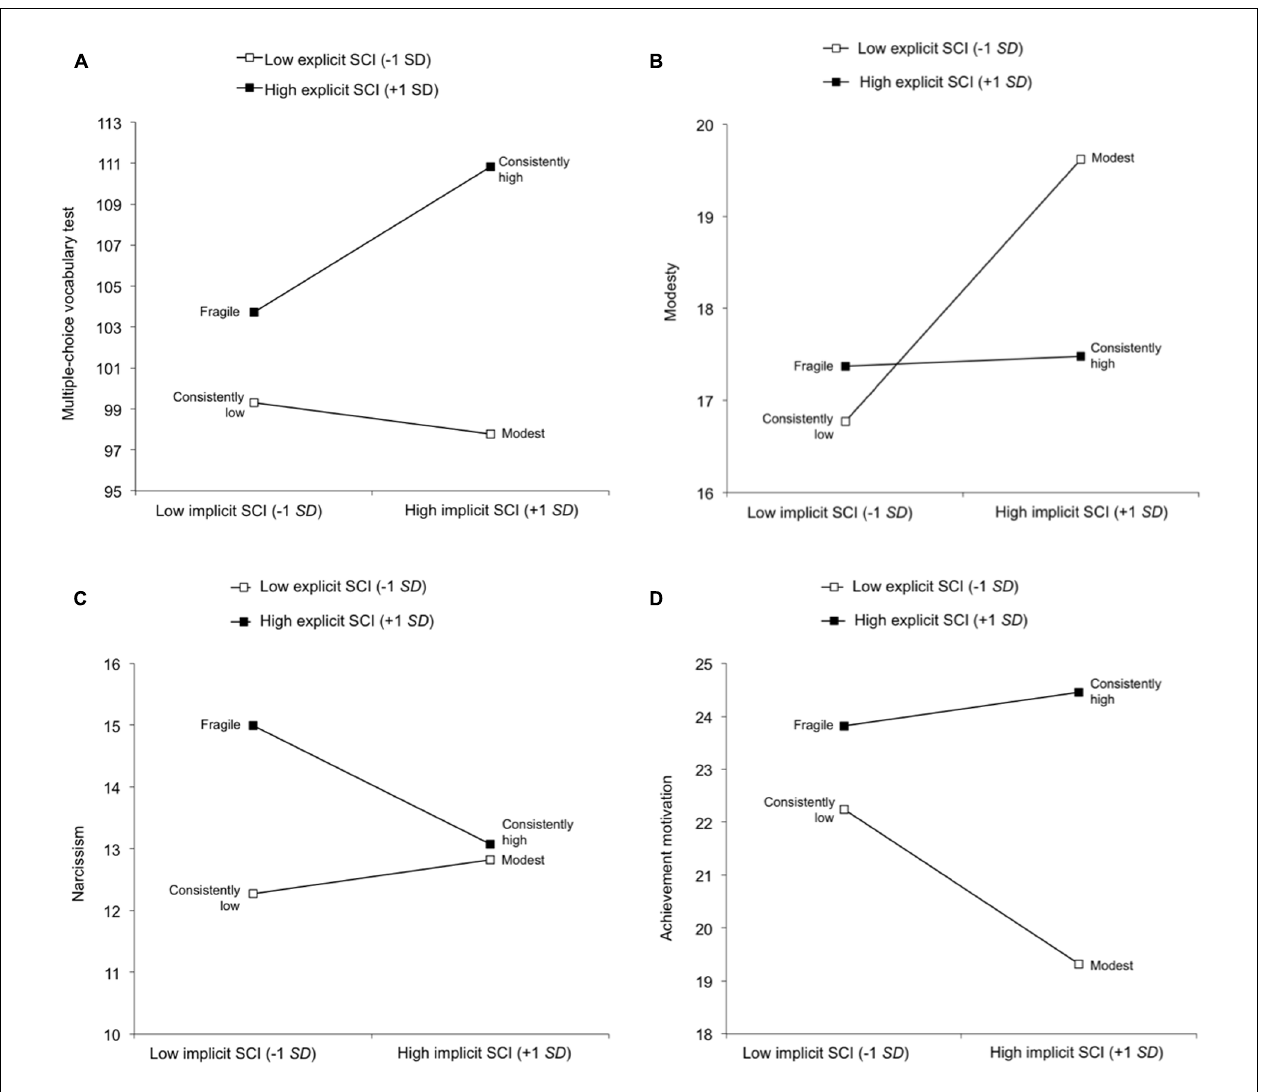
as a function of the explicit self-concept of intelligence and implicit self-concept of intelligence. (D) Predicted values for the achievement motivation scale as a function of the explicit self-concept of intelligence and implicit self-concept of intelligence. SCI = self-concept of intelligence; SD = standard